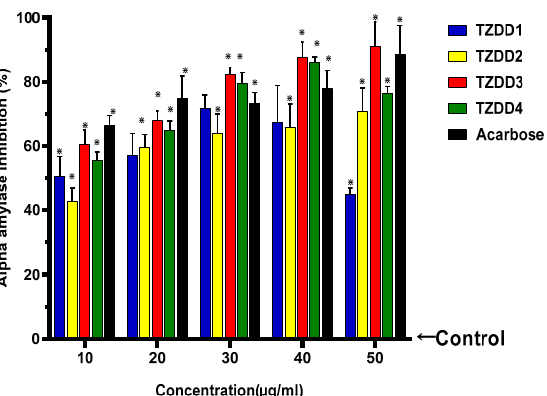
Figure 1. The inhibition of α -amylase activity by TZD-derivatives (10, 20, 30, 40 and 50 µg/mL). The results are represented in a clustered column. Data are presented as mean ± standard deviation values. The error bars correspond to the standard errors of the means, and asterisks (*) indicate a significant statistical difference relative to the control experiment ( p value ≤ 0.05). The arrow from the right pointing at the baseline at 0.0 represents the negative control, which is defined to have zero percent inhibition for the purpose of data normalization .